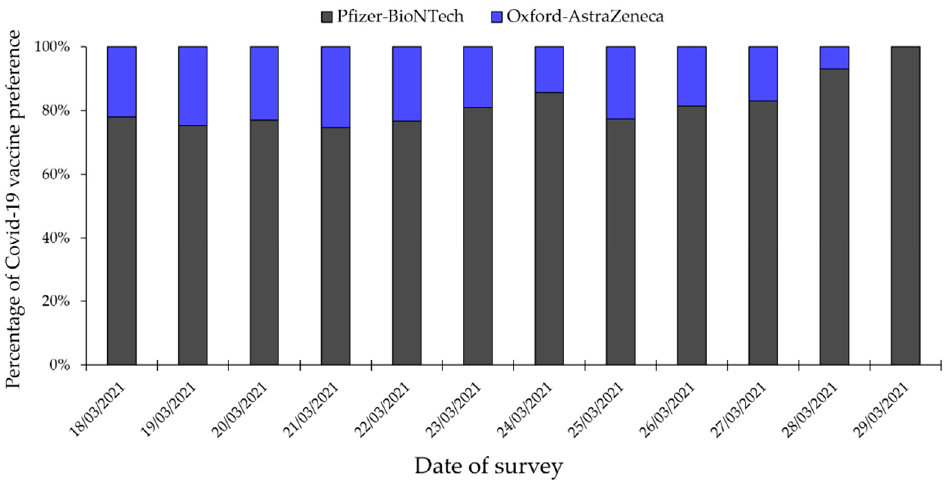
Figure 2. Change in COVID-19 vaccine preference over the survey dates (Pfizer-BioNTech vaccine vs. Oxford-AstraZeneca